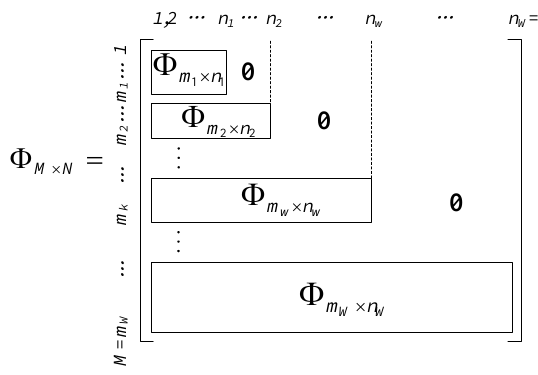
Figure 3. Joint sensing matrix for the general